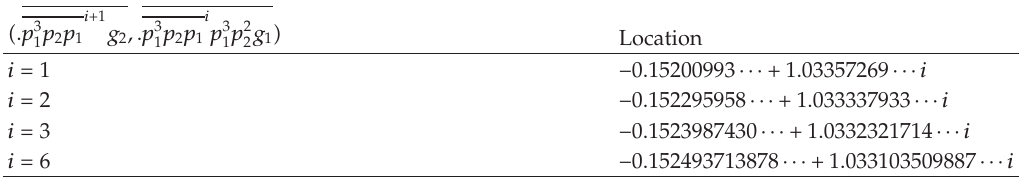
Table 6: Location of canonical quintuple-spiral medallions.